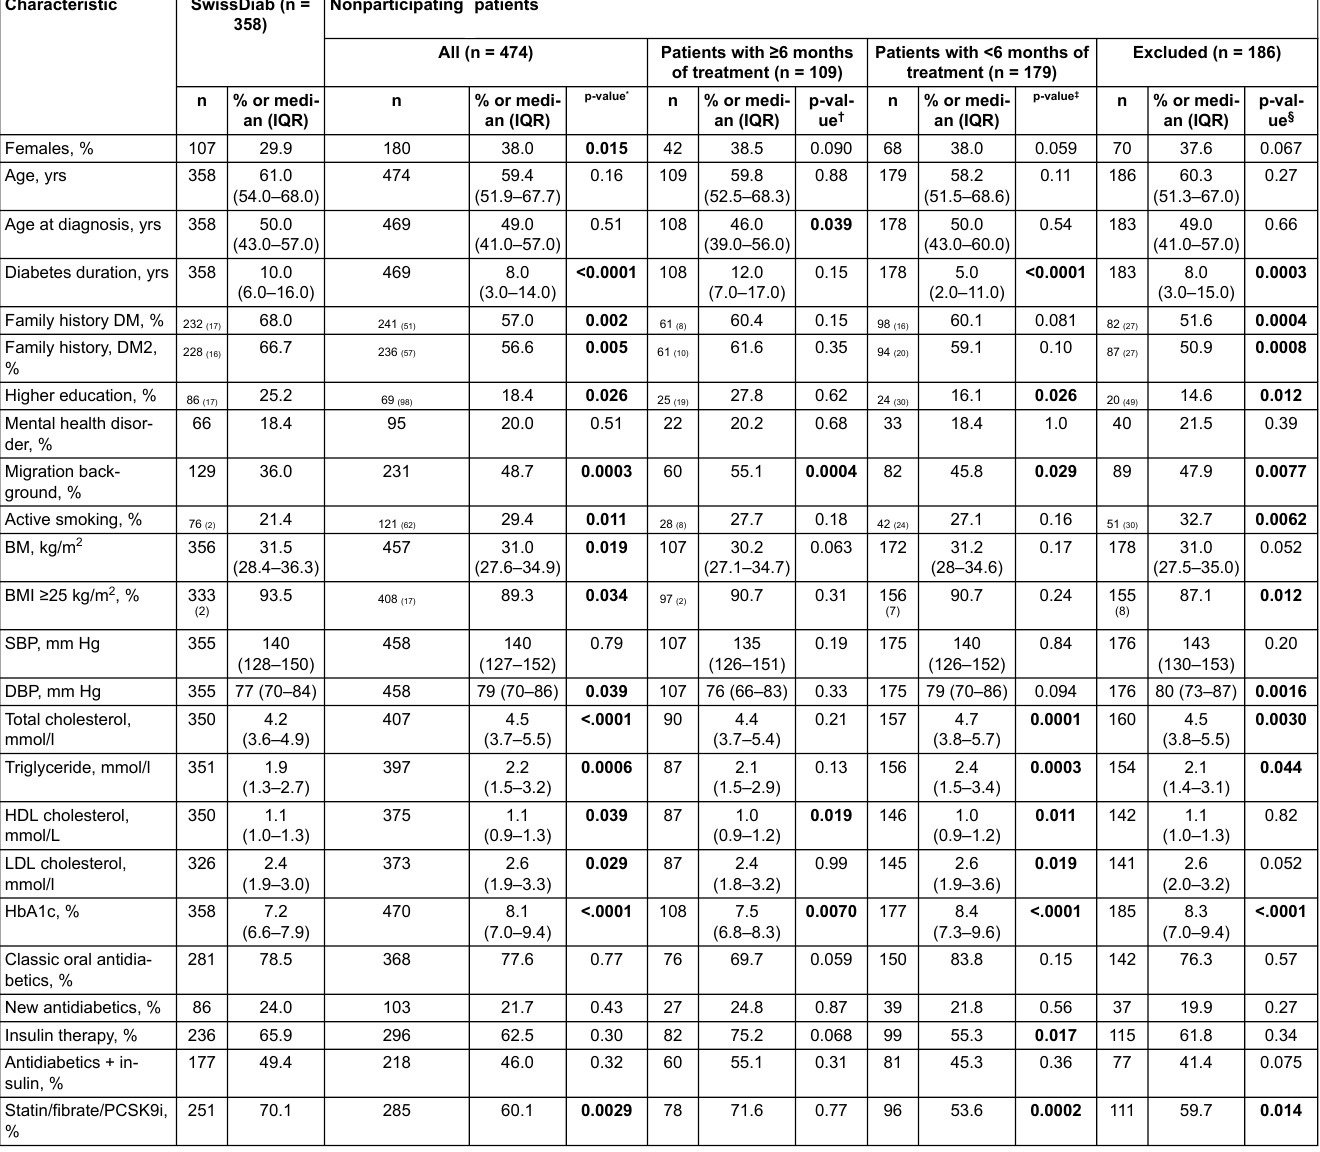
Table 3: Characteristics of SwissDiab participants and nonparticipating patients with DM2.